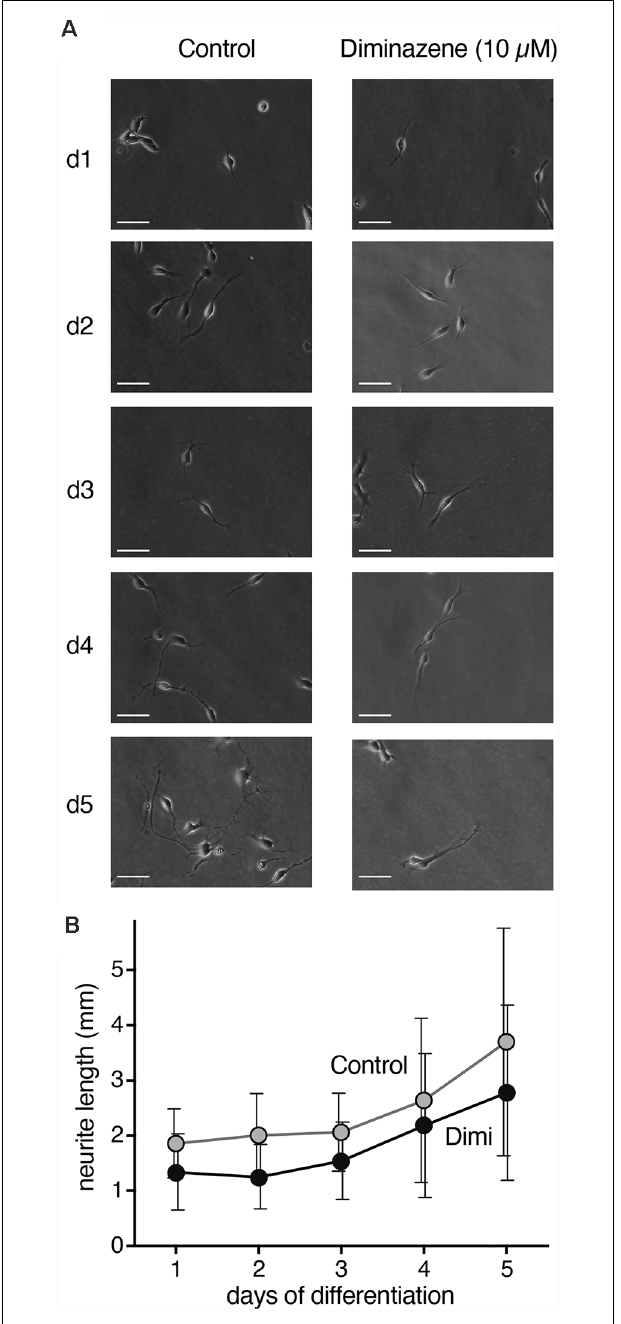
FIGURE 6 | Neurite length during differentiation of proliferating LUHMES cells into post-mitotic neurons. (A) Representative images of LUHMES cells at d1–d5, with and without incubation in diminazene (10 µ M). (B) Quantification of the total length of neurites of single cells at d1–d5. Dimi, diminazene. n = 26–60 neurites from 12–24 different